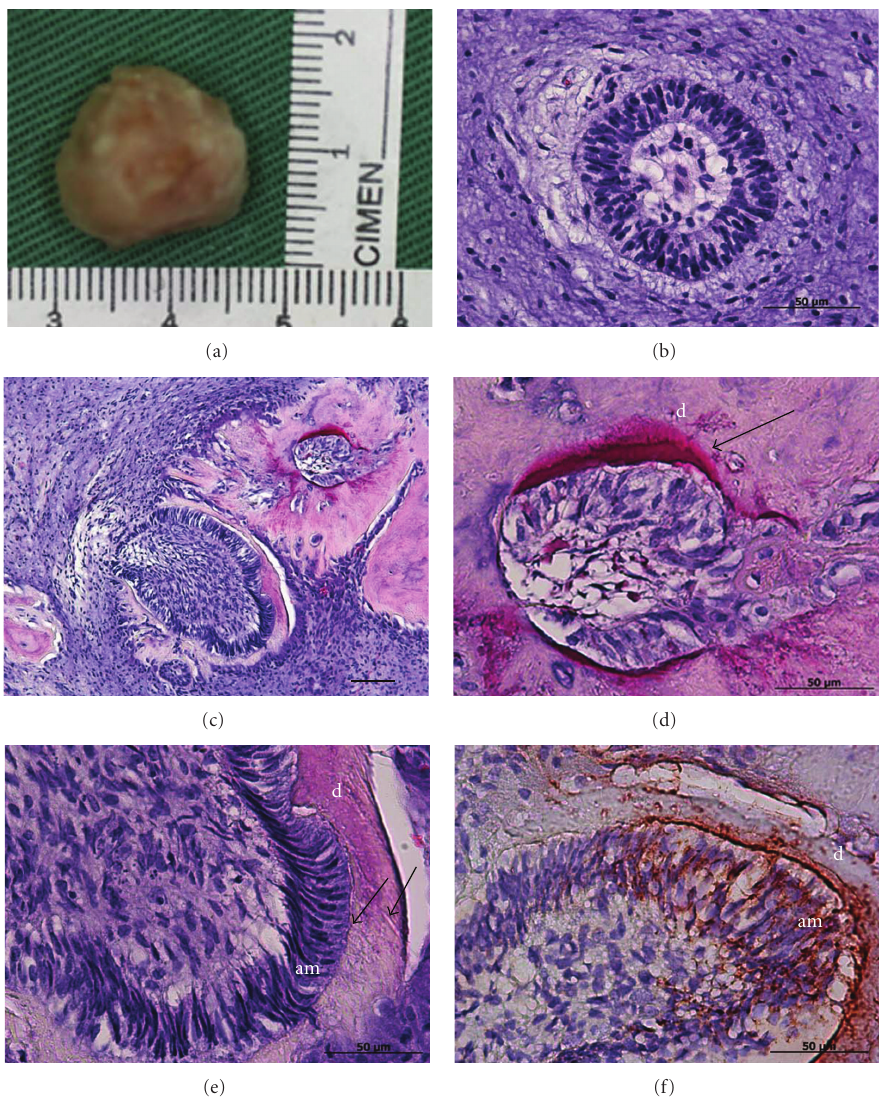
Figure 5: The implants at four weeks after transplantation. (a) Round-shaped implants were produced by the constructs formed between cultured enamel organ-derived epithelial (EOE) cells and dental pulp cells in a sca ff old. (b) An enamel organ-like structure associated with an epithelial cell cluster was seen in the implant. Columnar cells were organized in a circle and dental pulp cells embraced the enamel organ. (c) Enamel-like tissue formation on the surface of the dentin, stained with hematoxylin-eosin. (d) High magnification of (c), showing that enamel-like tissue (black arrow) stained with eosin was strongly displayed in the implant. (e) High magnification of (c), showing that tall columnar ameloblast-like cells (am) were aligned perpendicular to the dentin-like tissues (d). (f) High magnification of (c), showing that amelogenin expression was strongly identified in the enamel-like tissue adjacent to the dentin-like tissues and ameloblast-like cells. Scale bars: 50 μ m (b, d–f), 200 μ m (c)